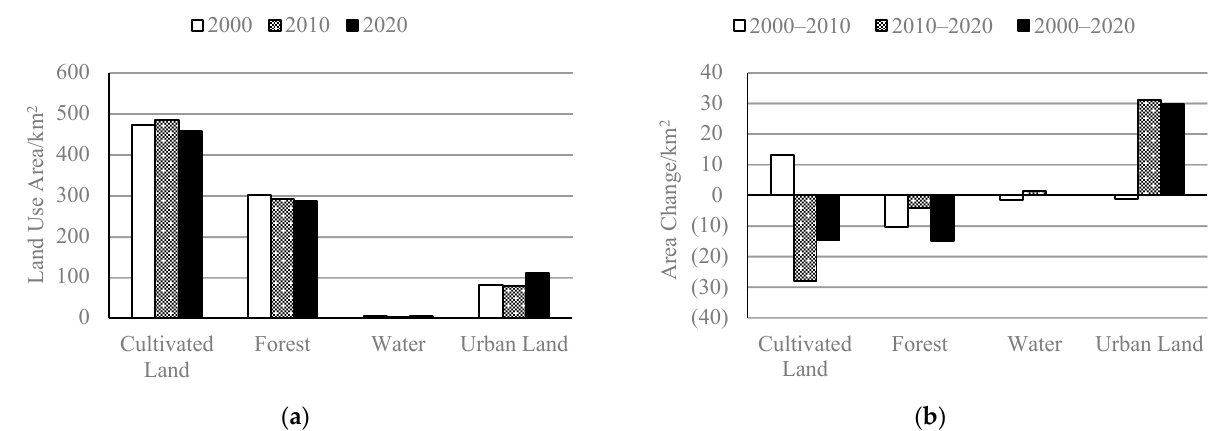
Figure 4. Situation analysis of Qishan. ( a ) Land use area in Qishan from 2000 to 2020; ( b ) land use area change in Qishan from 2000 to 2020.